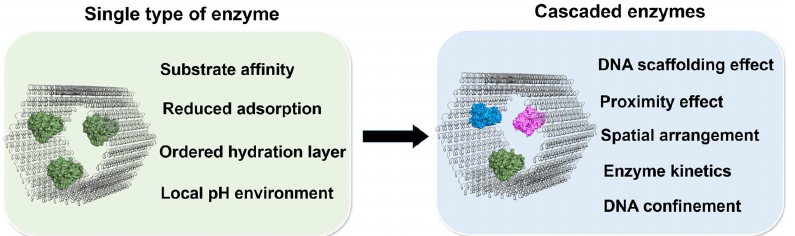
Figure 15. Mechanisms of the catalytic enhancement of single type of enzyme (either single or multiple in number) assembled on the DNA scaffold or the enhanced efficiency of enzyme cascade reactions on the DNA scaffold.